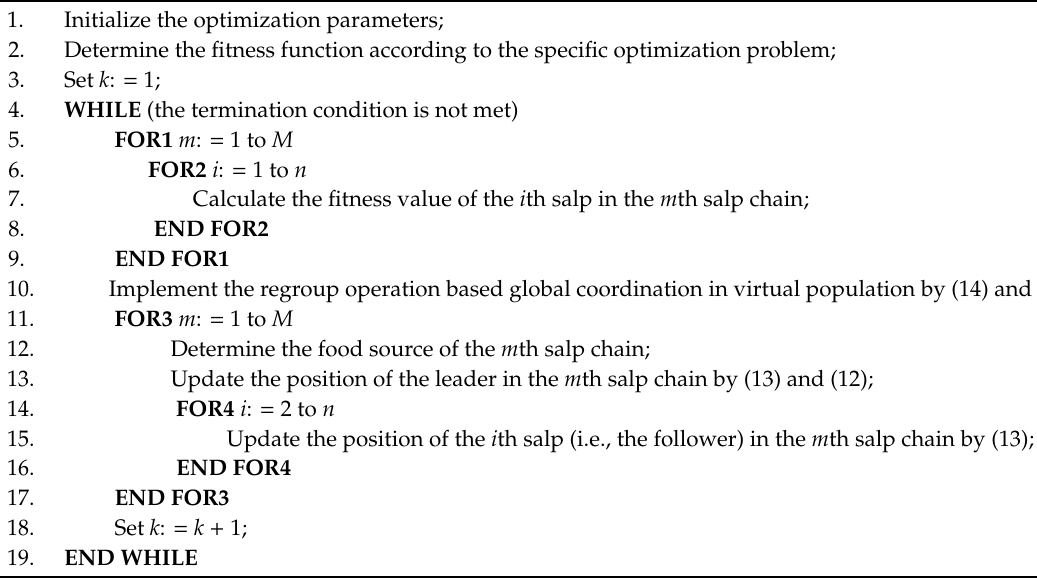
Table 1. The optimization procedure of MSSA (memetic salp swarm